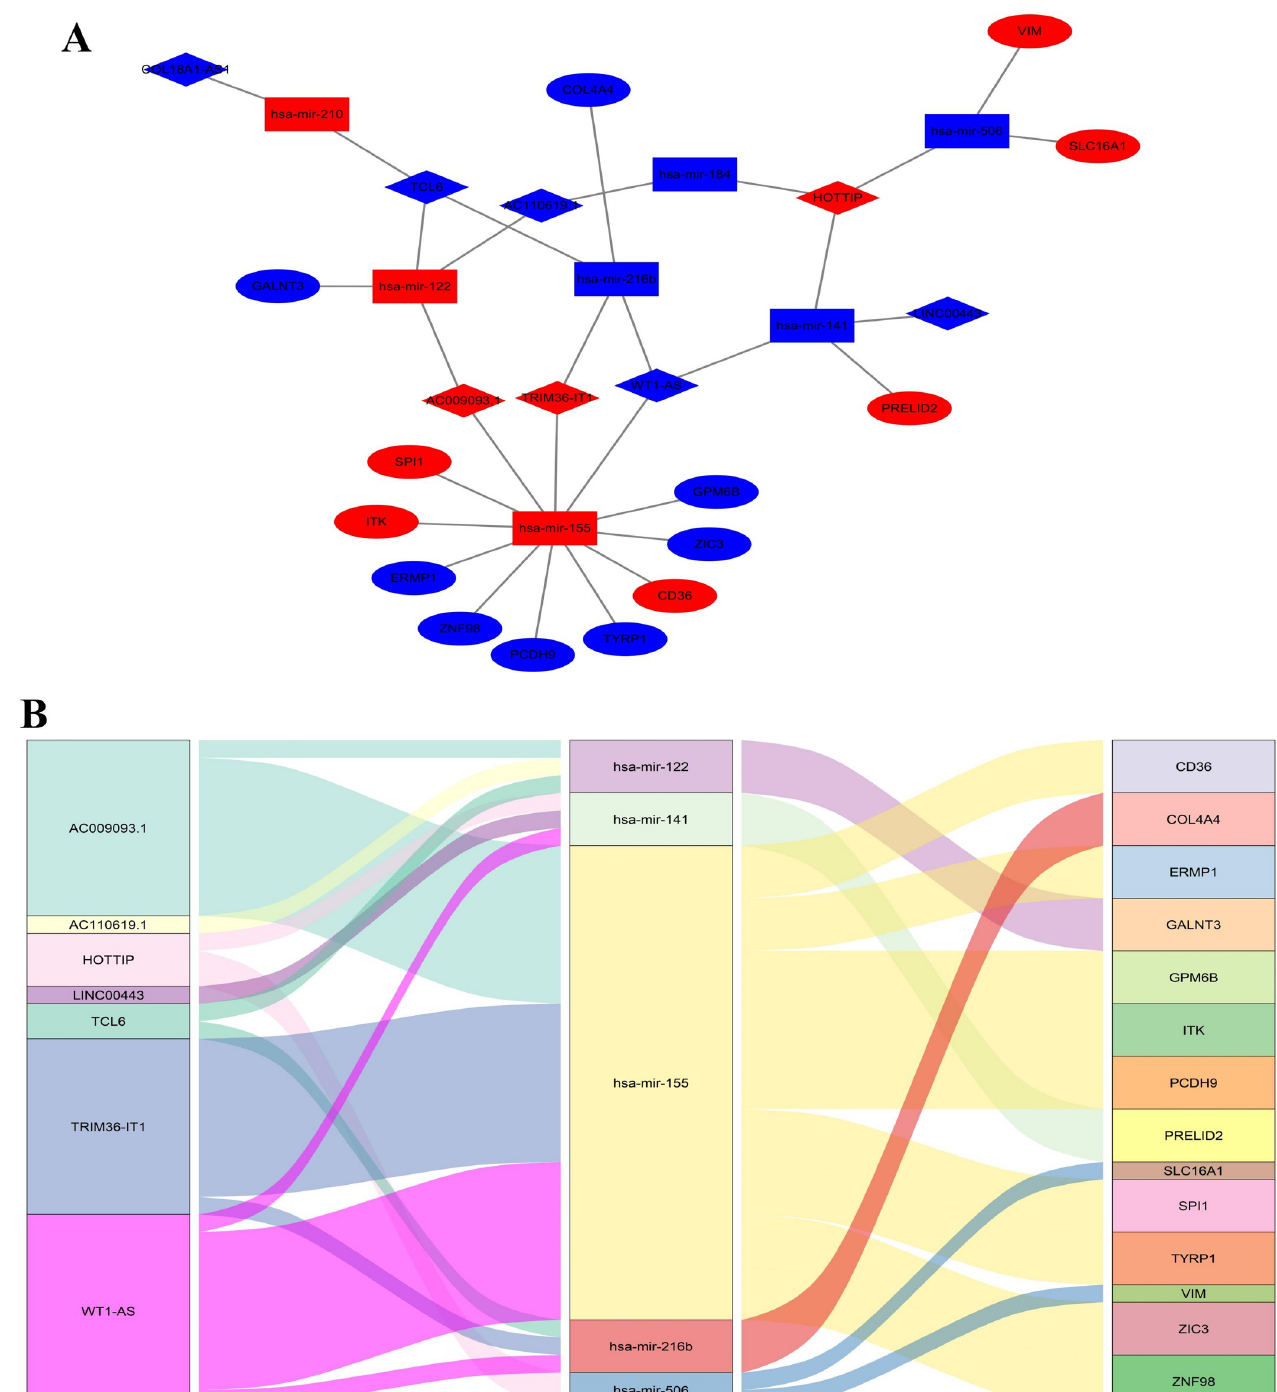
Fig 7. The ceRNA sub-network of the DElncRNA-mediated ceRNA network. (a) The ceRNA sub-network of eight lncRNAs. The diamond was lncRNA, the rectangle was miRNA, and the ellipse was mRNA. Red indicated upregulation, and blue indicated downregulation. (b) The constructed snakey diagram. All involved RNAs were associated with